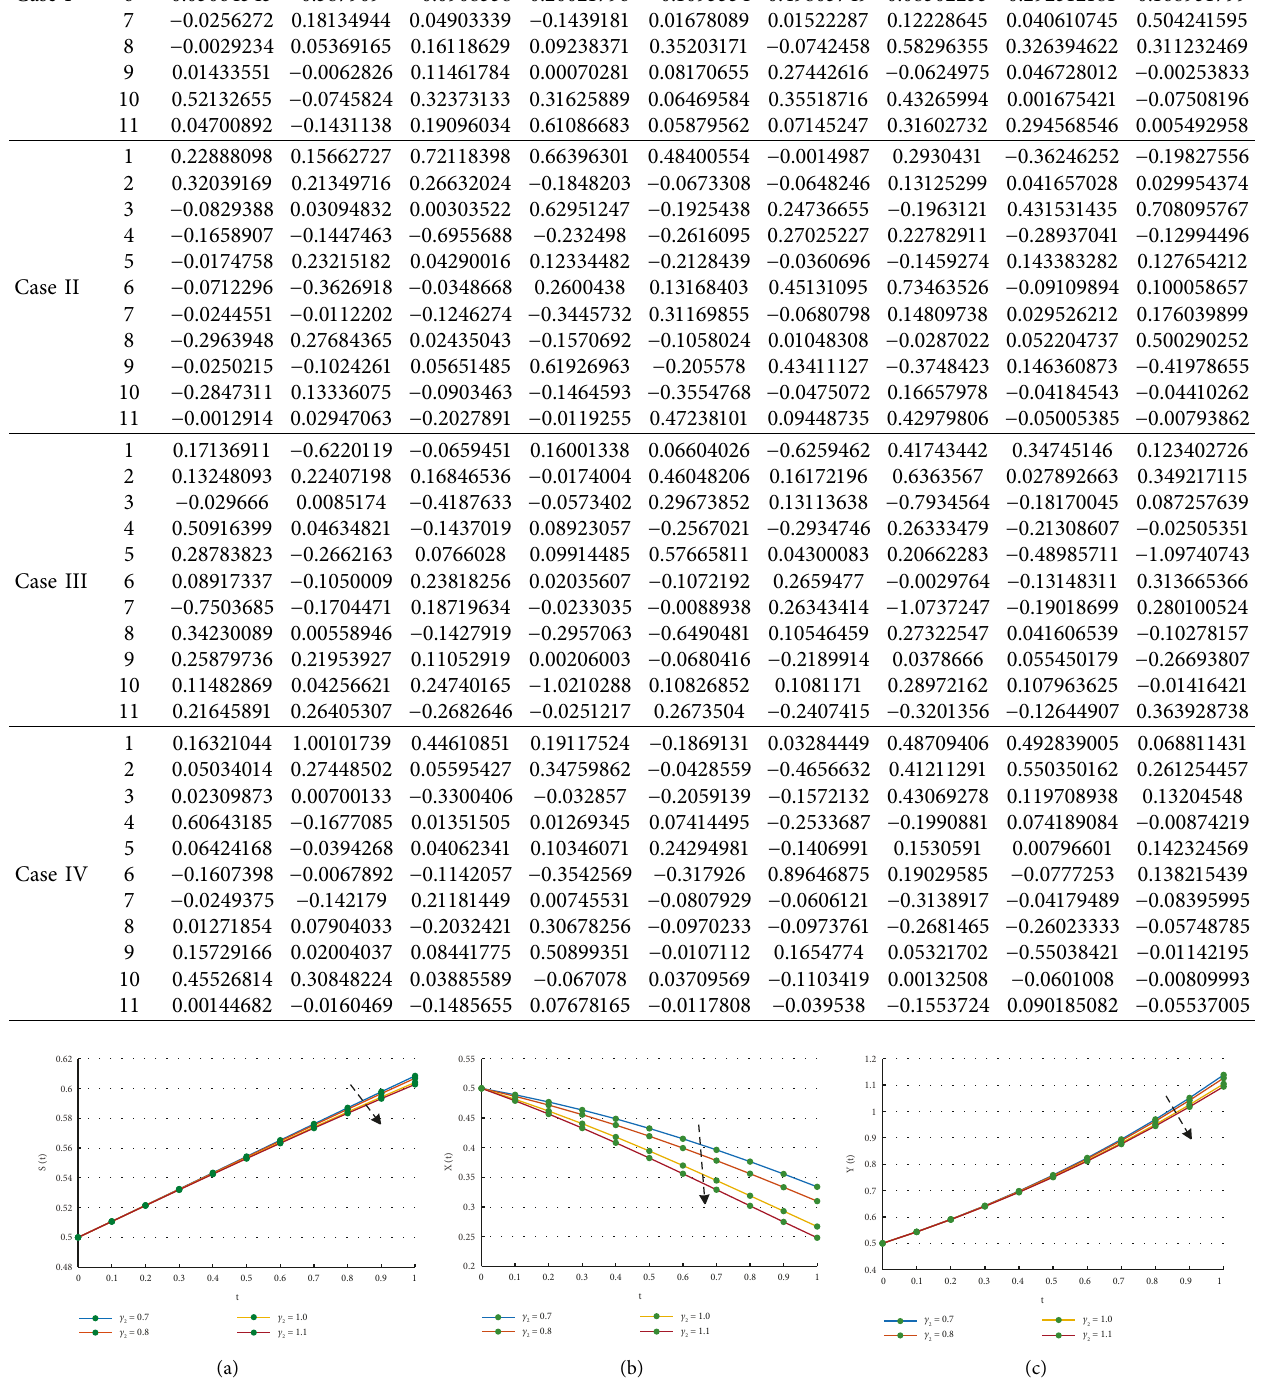
Figure 21: Comparison between solutions obtained by the LeNN-WOA-NM algorithm under the influence of variations in c population densities of the prey-predator model. (a) Approximate solutions for population density of local prey. (b) Approximate solutions for population density of immigrant prey. (c) Approximate solutions for population density of the